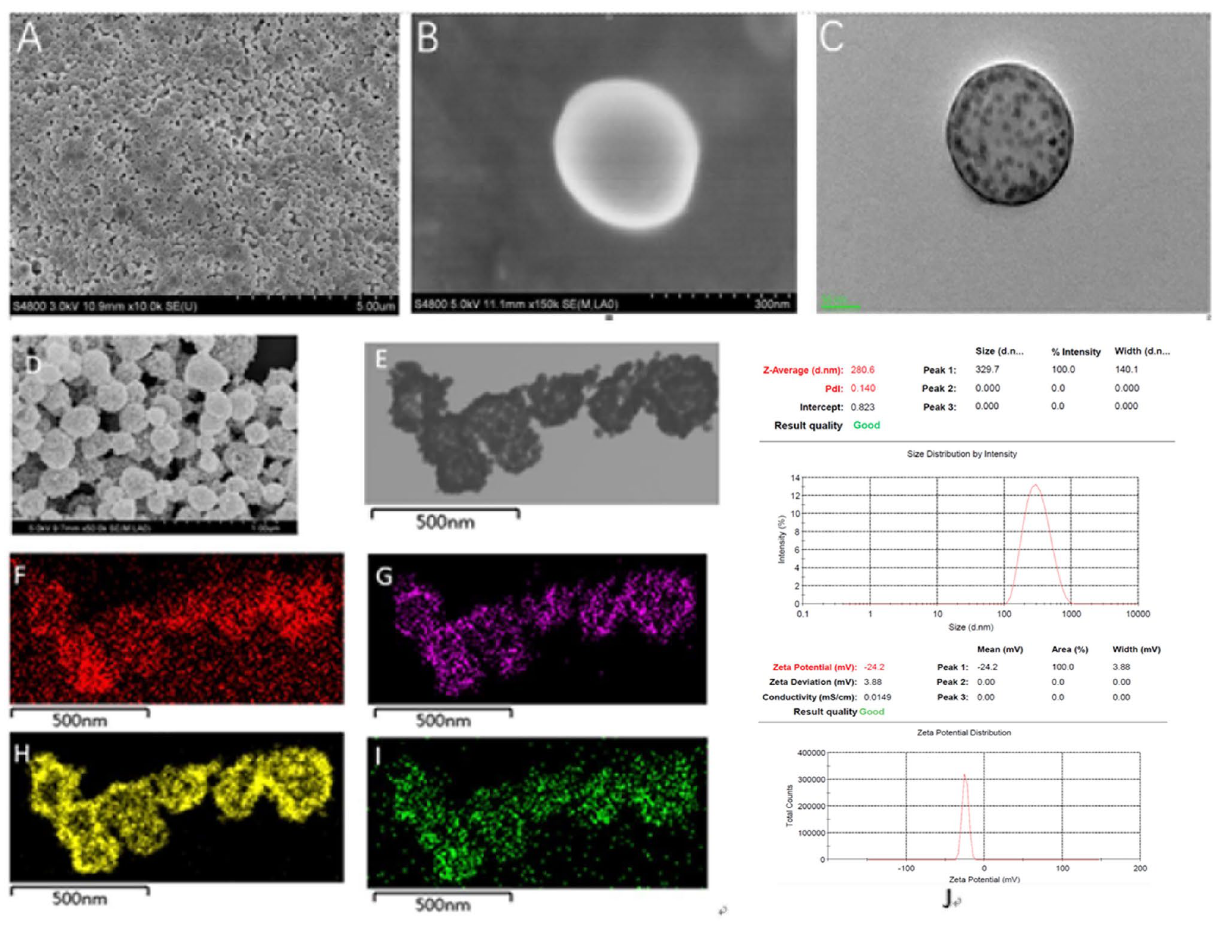
Figure 1. ( A ) SEM image of SPIOs@PLGA (scale bar = 5 μm); ( B ) SEM image of SPIOs@PLGA (scale bar = 300 nm); ( C ) TEM image of SPIOs@PLGA; ( D ) SEM image of SPIOs@PLGA@Au (scale bar = 1 μm); ( E